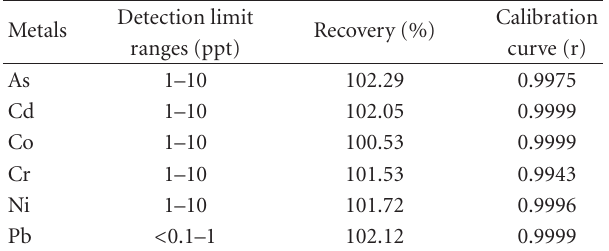
Table 2: Percentage recovery of metals for water analysis by ICP-